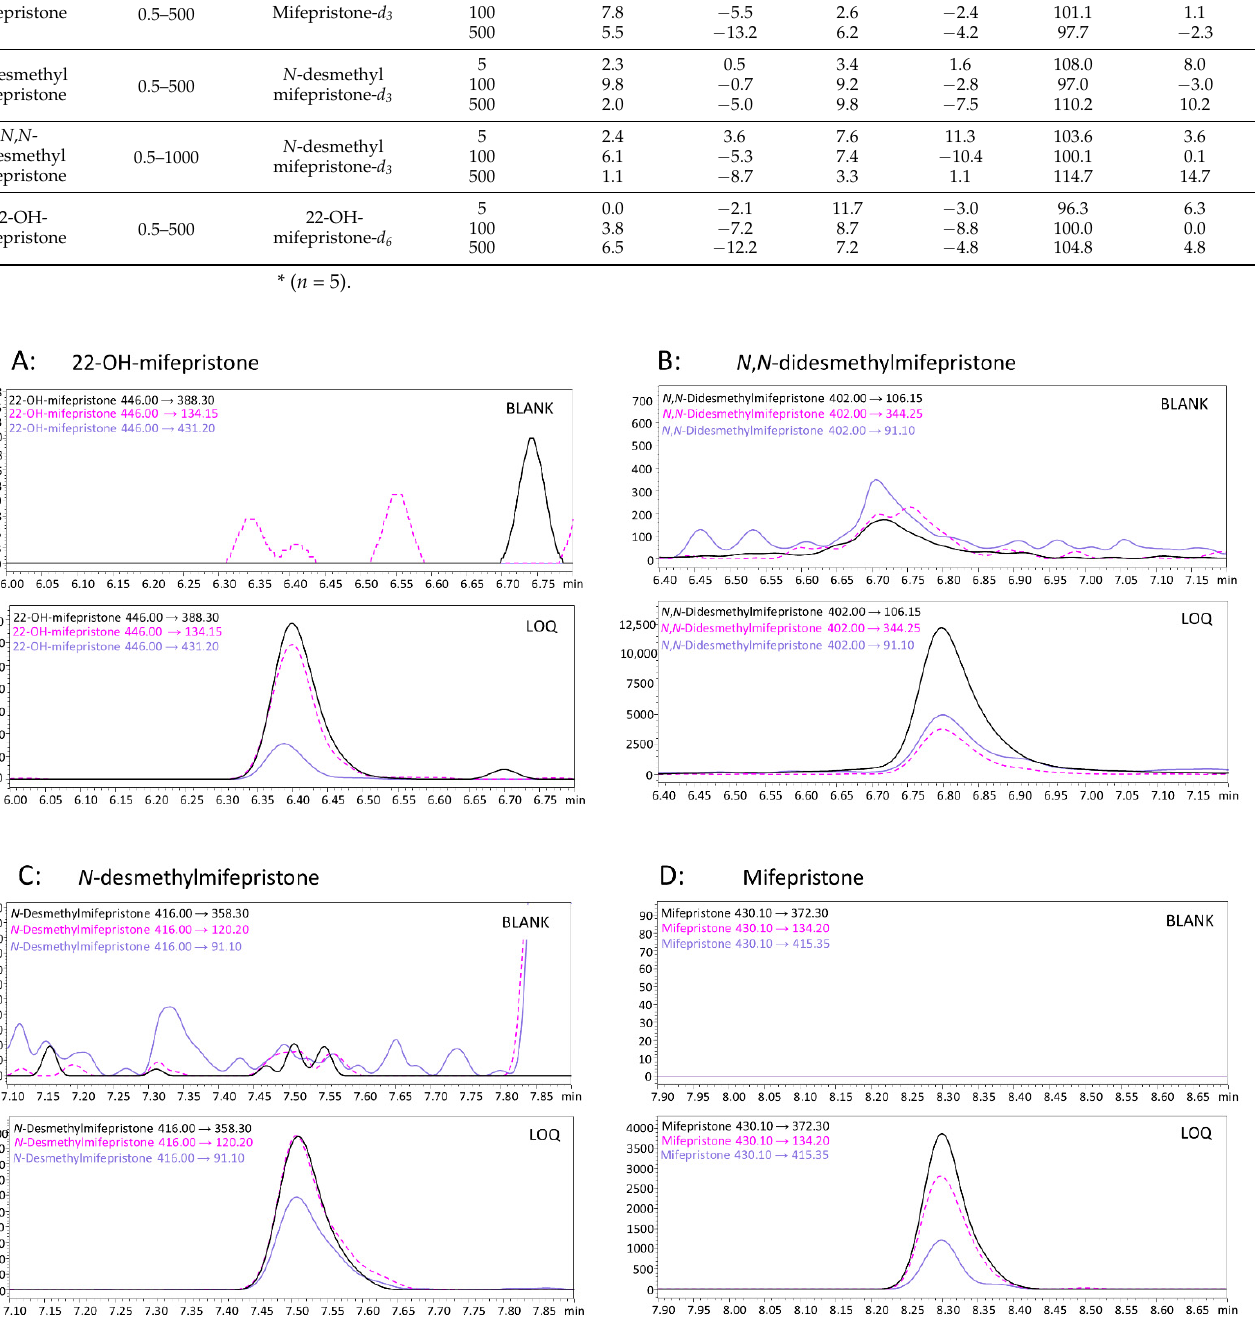
Figure 1. Multiple reaction monitoring (MRM) chromatograms of blank samples and LOQ samples achieved for determined compounds: ( A ) 22-OH-mifepristone; ( B ) N,N -didesmethyl-mifepristone; ( C ) N -desmethyl-mifepristone; and ( D ) mifepristone.